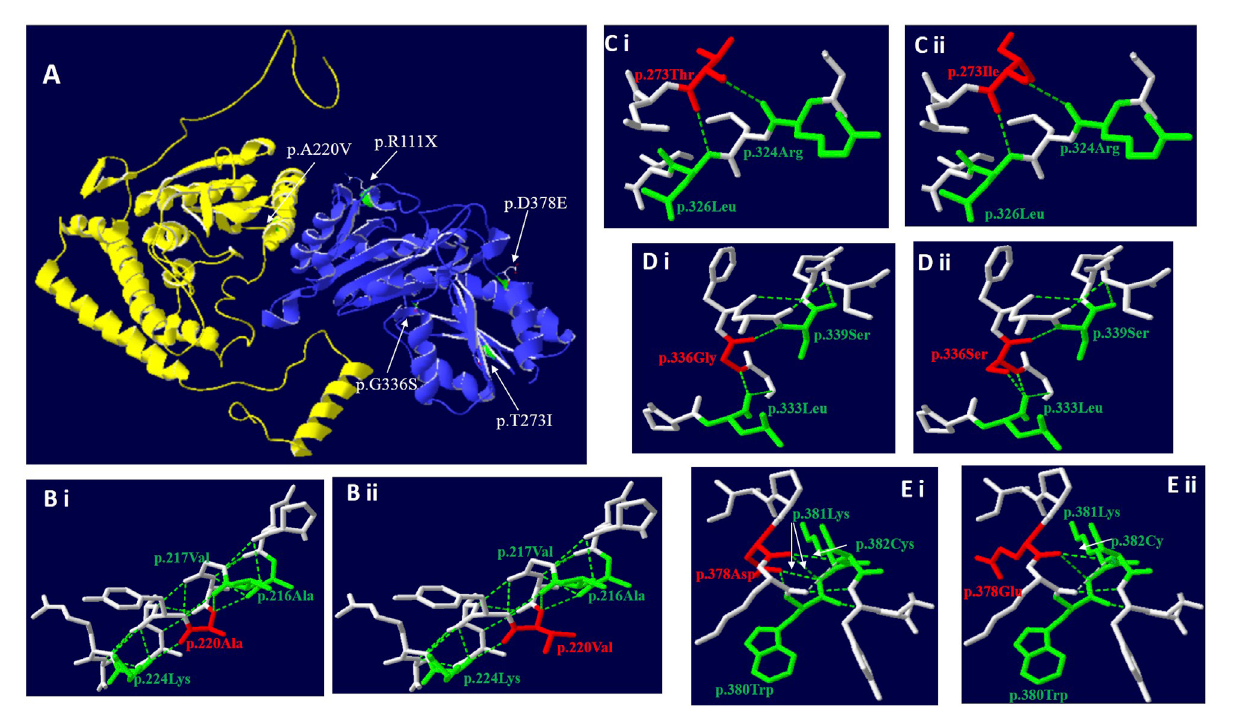
FIGURE 2 Three-dimensional structure of BCKDHA and BCKDHB (wild-type and mutant). (A) Overall structure of the BCKD protein. The chain α was highlighted in yellow, while chain β in blue. The location of the missense mutations were mapped to the regions of the protein in green and marked with white arrows. (B) The p. A220V missense mutation didn ’ t affect hydrogen bond linkage with adjacent amino acids, but changes the side chain structure. (C) The p.T273I missense mutation didn ’ t affect hydrogen bond linkage with R324 and L326, but changes the side chain structure. (D) The p.G336S missense mutation could create a new hydrogen bond between S336 and the Leucine (Leu) at position L333. (E) The p. D378E missense mutation could disrupt a hydrogen bond between E378 and K381 and between E378 and W380,